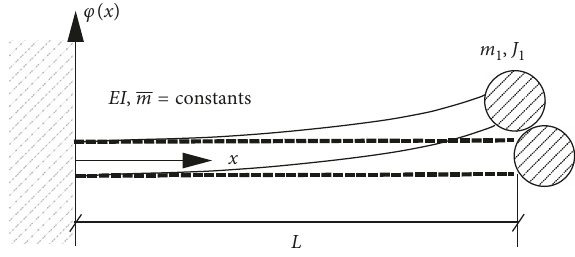
Figure 2: Vibration model of cantilever beam with additional mass.